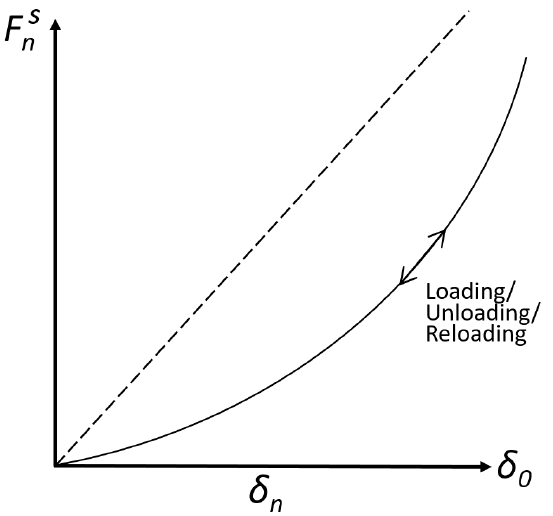
Figure 3. Hysteretic spring force–displacement relationship used in the Hertz–Mindlin contact model (HMCM). Redrawn from Ucgul et al. [29]. The dashed line contrasts the basic linear elastic model relationship.